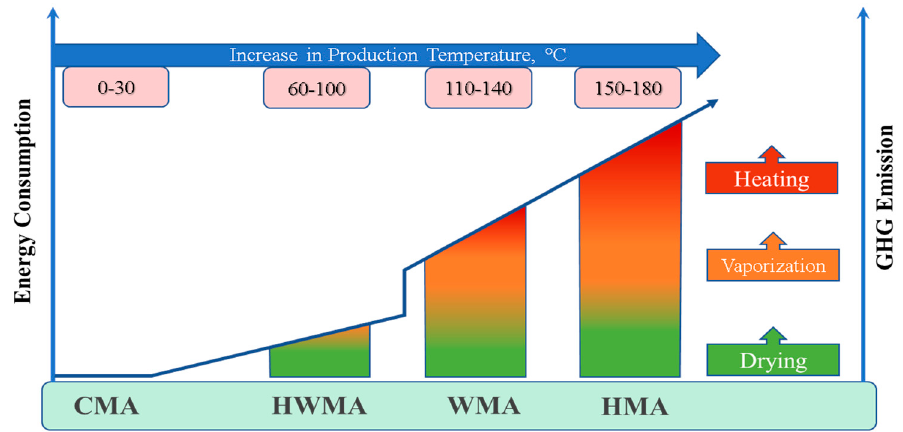
Figure 1. Classification of asphalt mixes based on production temperature [11].